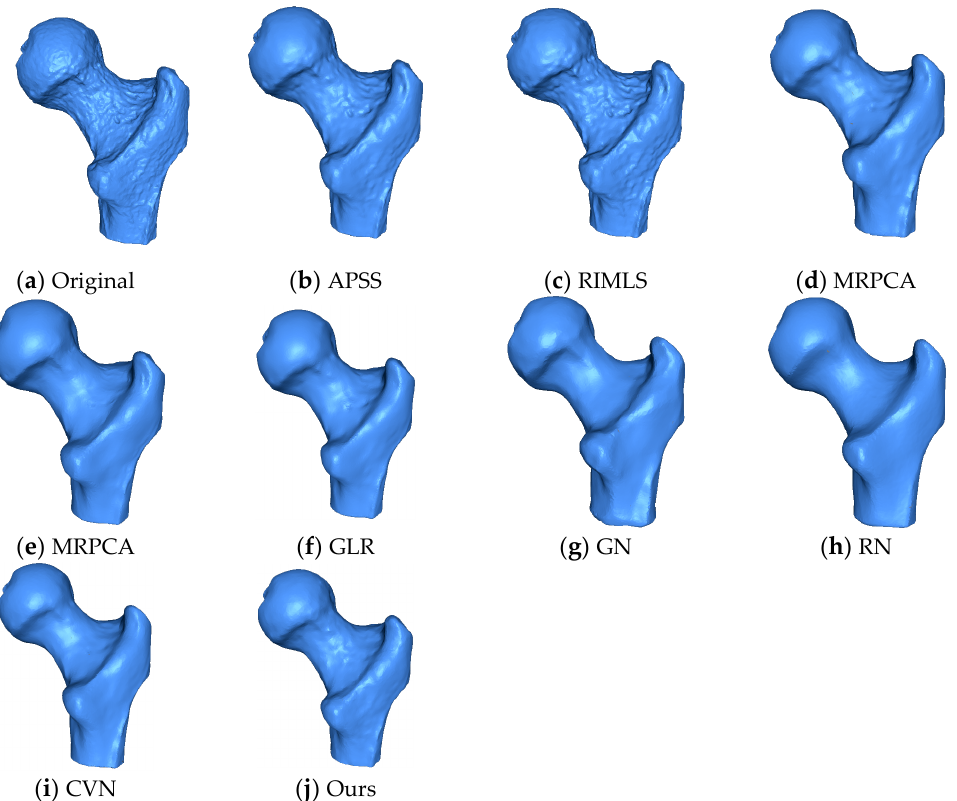
Figure 8. The ball joint model. We can see that the proposed method was able to preserve sharp features effectively when compared to the state-of-the-art methods. The surface was reconstructed using the ball pivoting algorithm.